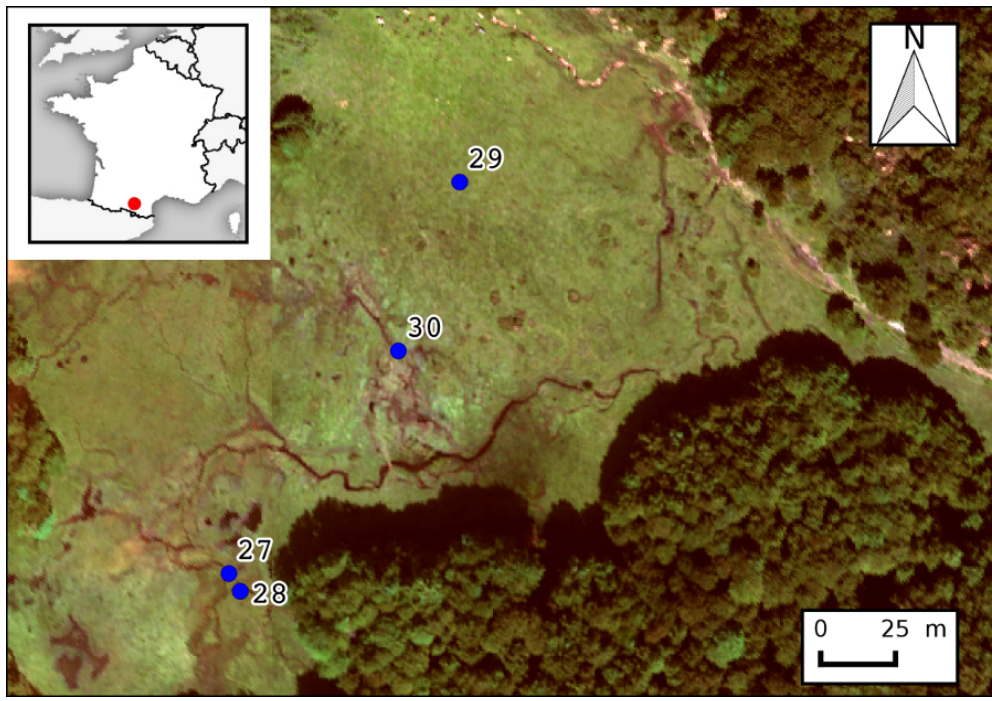
Figure A23. Location of the in situ spectroradiometer measurements for the plots of Carex sp. homogeneous vegetation